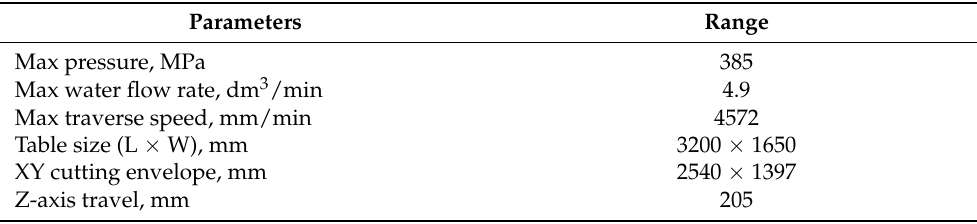
Table 4. JetMachining ® Center type 55100 specifications.